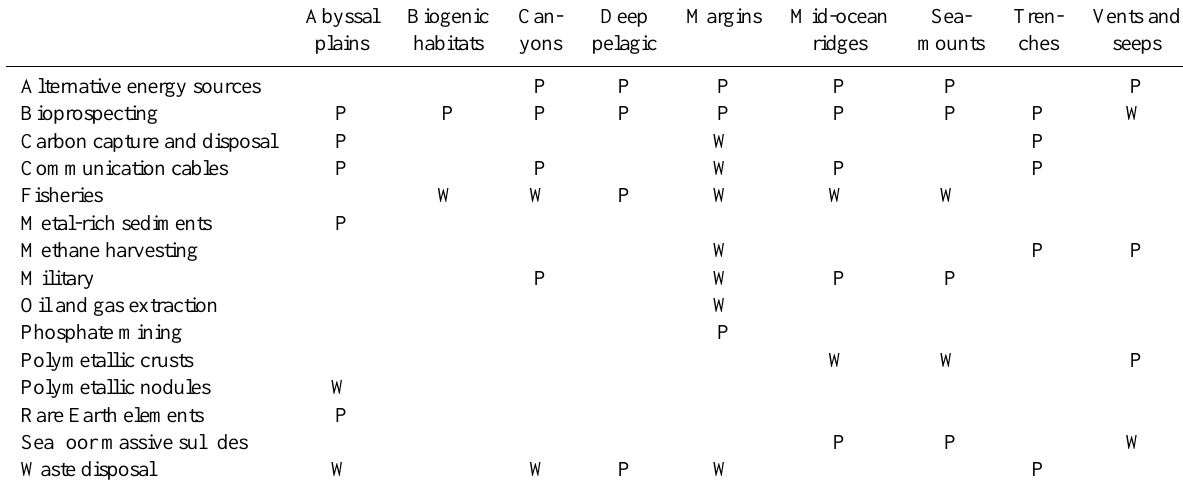
Table 1. The distribution of regulating and provisioning services among the habitats present in the deep sea. Blank = unknown or not present. P = present. W = widespread or